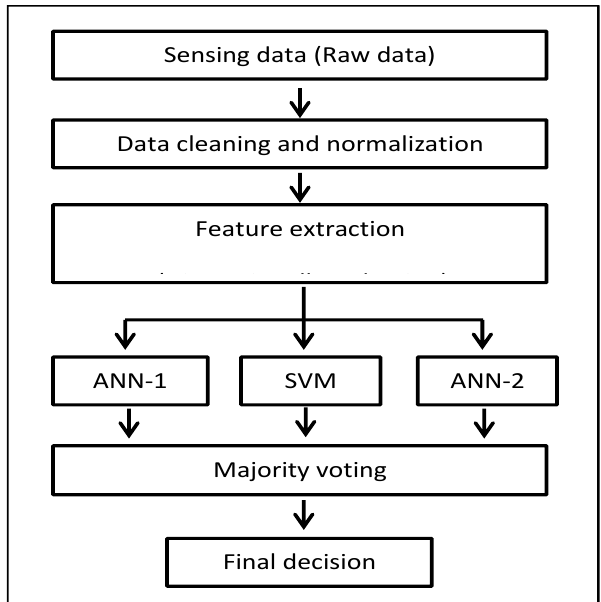
Figure 8. Implemented model architecture. Majority voting combination is used for final